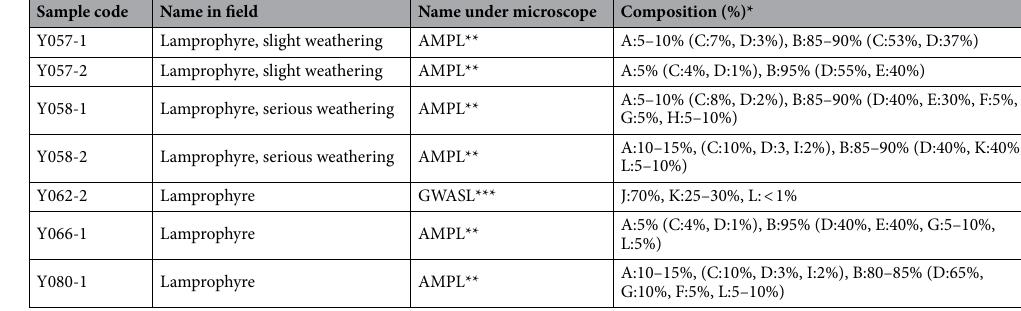
Table 2. samples and analysis result of lamprophyre from Huaniushan. *A: phenocryst, B:matrix, C:augite, D: plagioclase, E: biotite, F: epidote, G: chlorite, H: calcite, I: quartz, J: Siliceous, K: sericite, L: